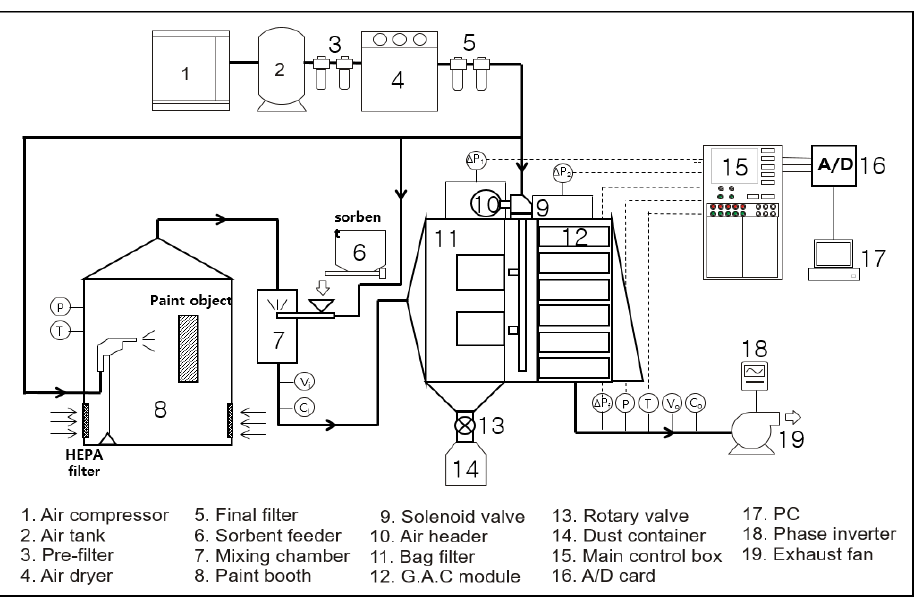
Table 3. Summaries of the experimental